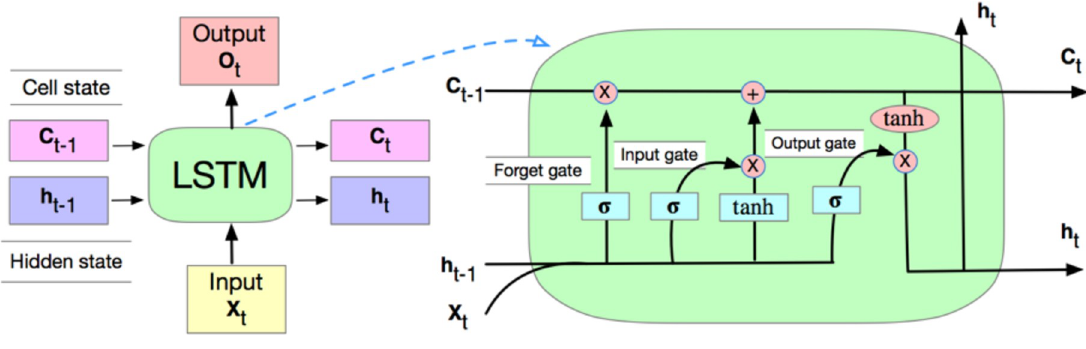
Fig 1. Graph illustration of LSTM